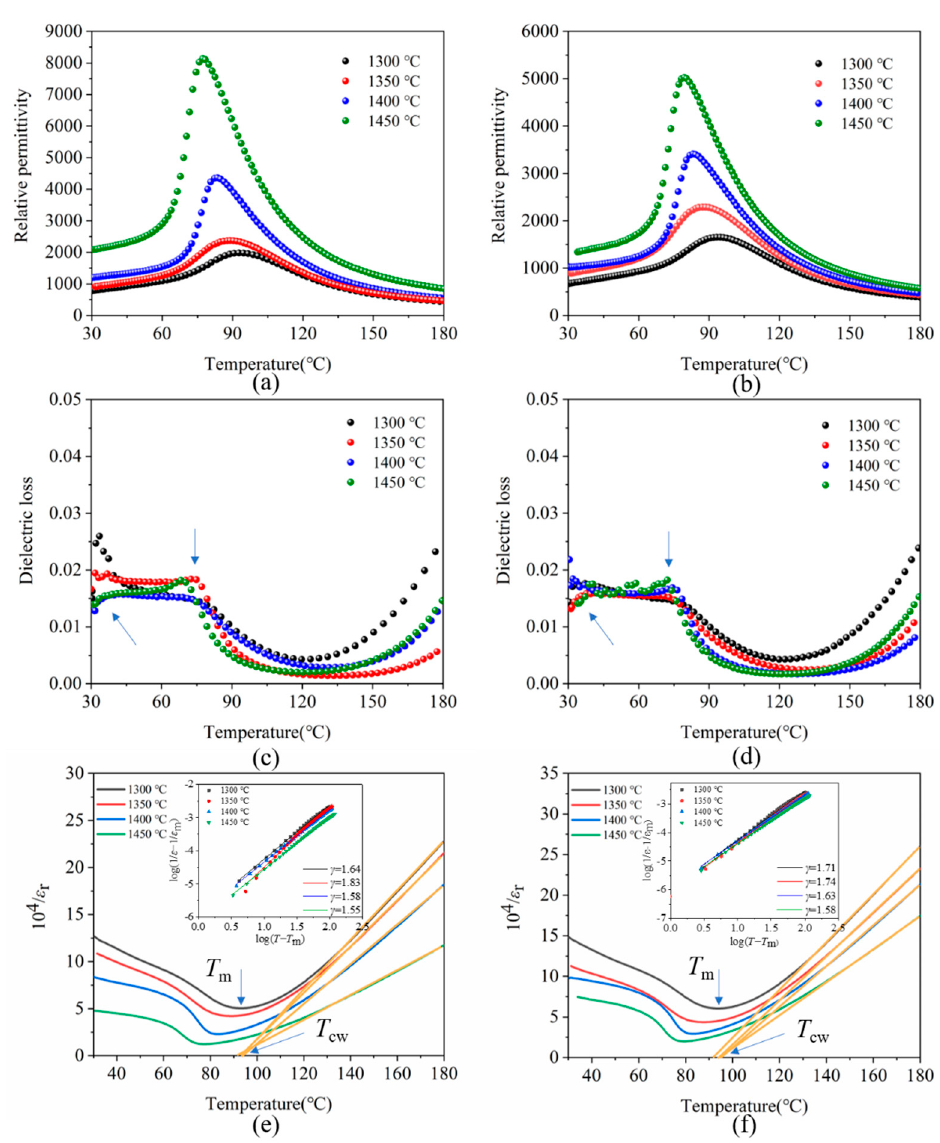
Figure 7. ( a ) Relative permittivity, ( c ) dielectric loss, and ( e ) inverse relative permittivity as a function of measuring temperature and sintering temperature of porous BCZT piezoelectric ceramics sample (parallel to the freezing direction). ( b ) Relative permittivity, ( d ) dielectric loss, and ( f ) inverse relative permittivity as a function of measuring temperature and sintering temperature of porous BCZT piezoelectric ceramics sample (perpendicular to the freezing direction). (Insets are the corresponding curves of log(1/ ε − 1/( ε r ) m ) against log( T − T m ).) Further confirmation of the ferroelectric diffusivity of the phase transition of porous BCZT ceramics sintered at different temperatures was quantitatively characterized.